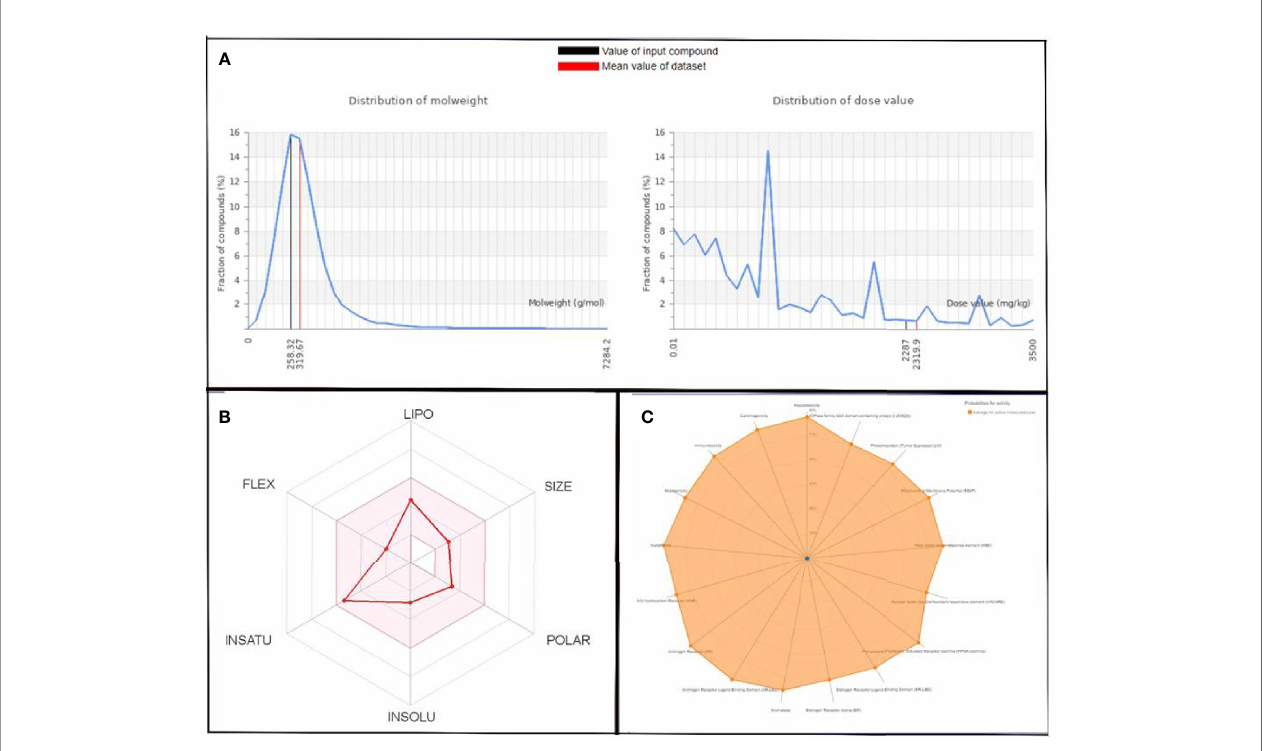
FIGURE 6 | (A) Graphical representation of molecular weight and dose value distribution of QSSM 1112. (B) Swiss-ADME generated bioavailability radar chart for QSSM 1112. Pink area indicates the oral bioavailability of QSSM 1112. (C) Radar chart demonstrating various predicted toxicity pro fi les of QSSM 1112 through